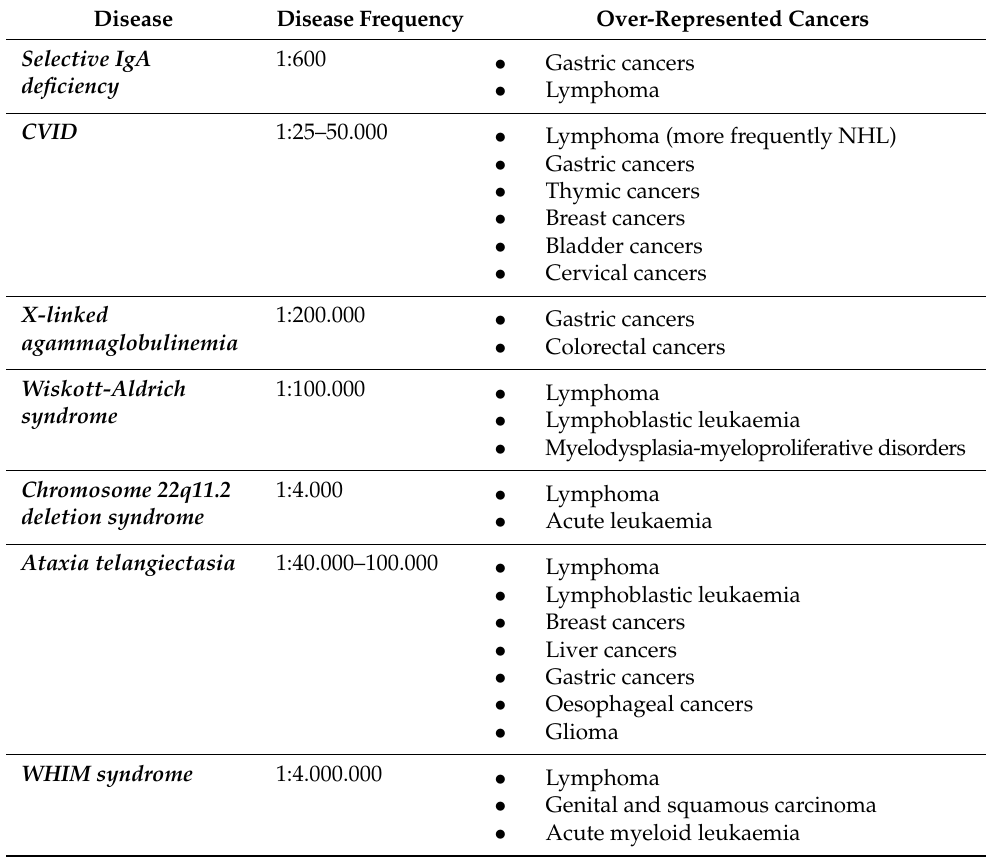
Table 2. Malignancy patterns of various primary immunodeficiency